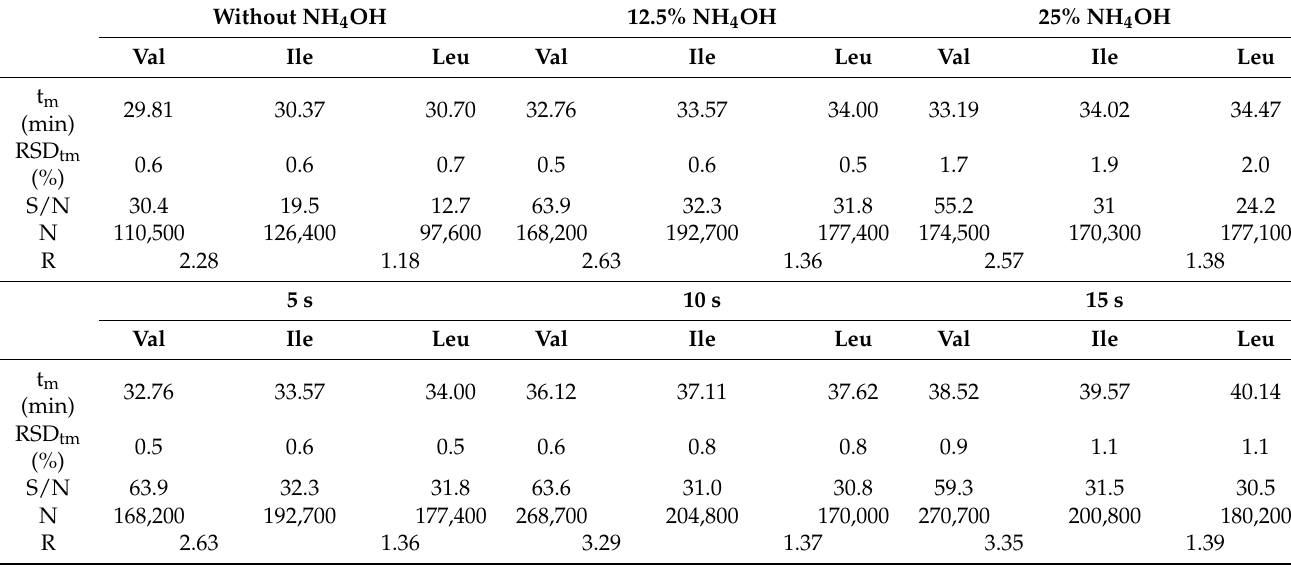
Table 1. Optimization of the NH 4 OH concentration and time of its hydrodynamic injection into the separation capillary.